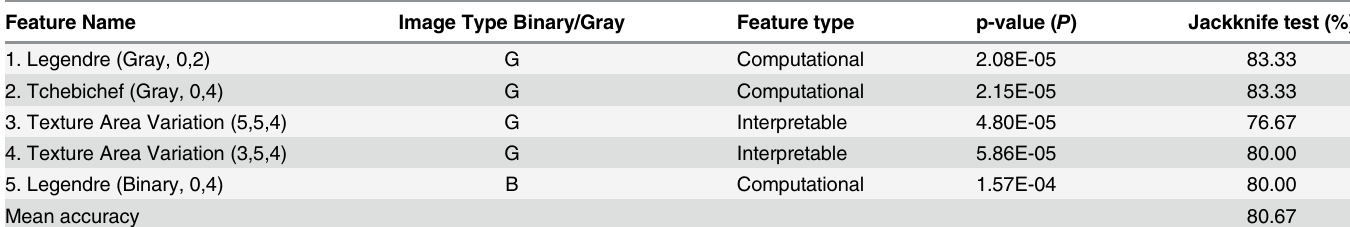
Table 2. The top – 5 features with the smallest P values for microglia.